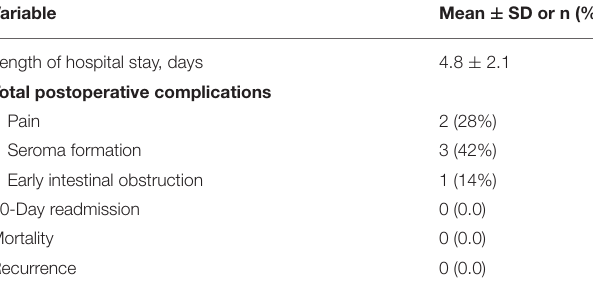
TABLE 3 | Postoperative